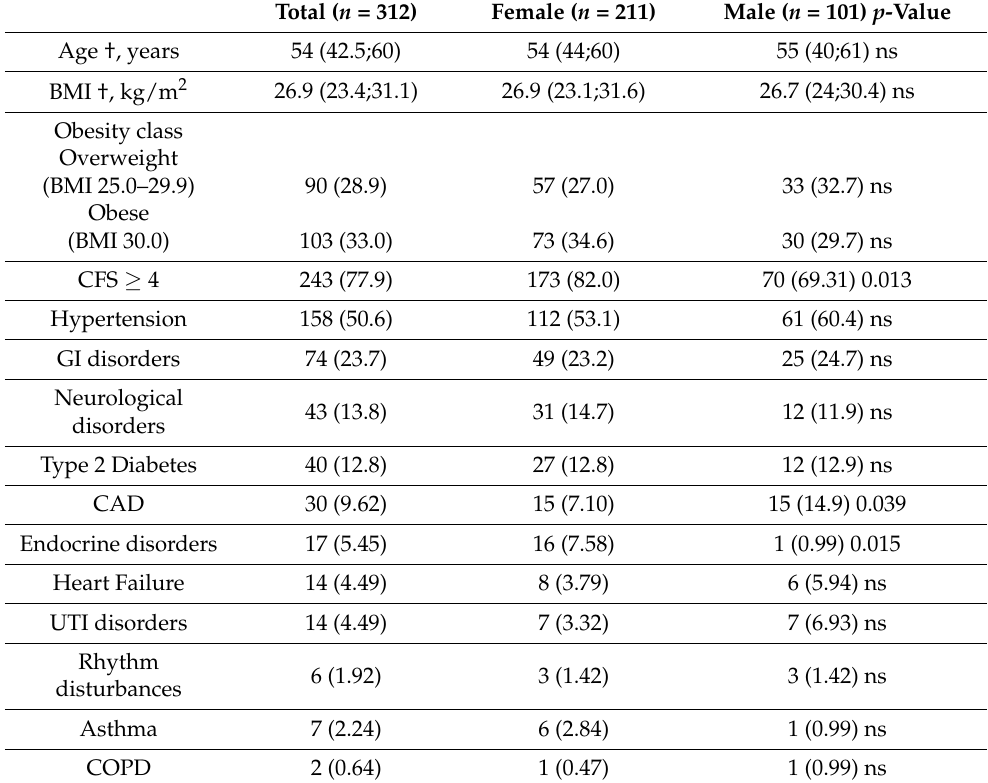
Table 1. Clinical characteristics and comorbidities in participants after COVID-19